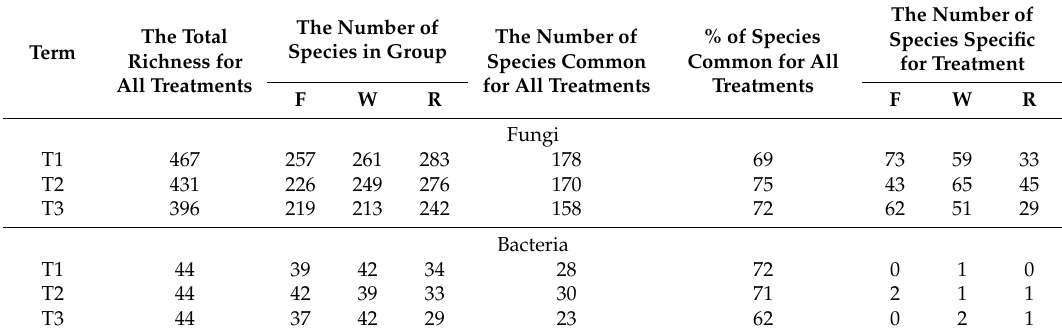
Table 4. Beta-diversity of fungal and bacterial OTUs as influenced by